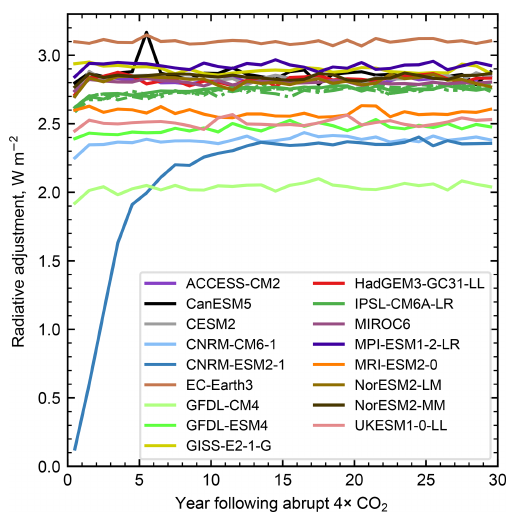
Figure 2. Transient response of the stratospheric temperature ad- justment to a 4 × CO 2 forcing. The small spike in year 6 in CanESM5 is due to an unseasonably low tropical tropopause in July of year 6, resulting in much of the temperature adjustment at the 100hPa level to be counted in the